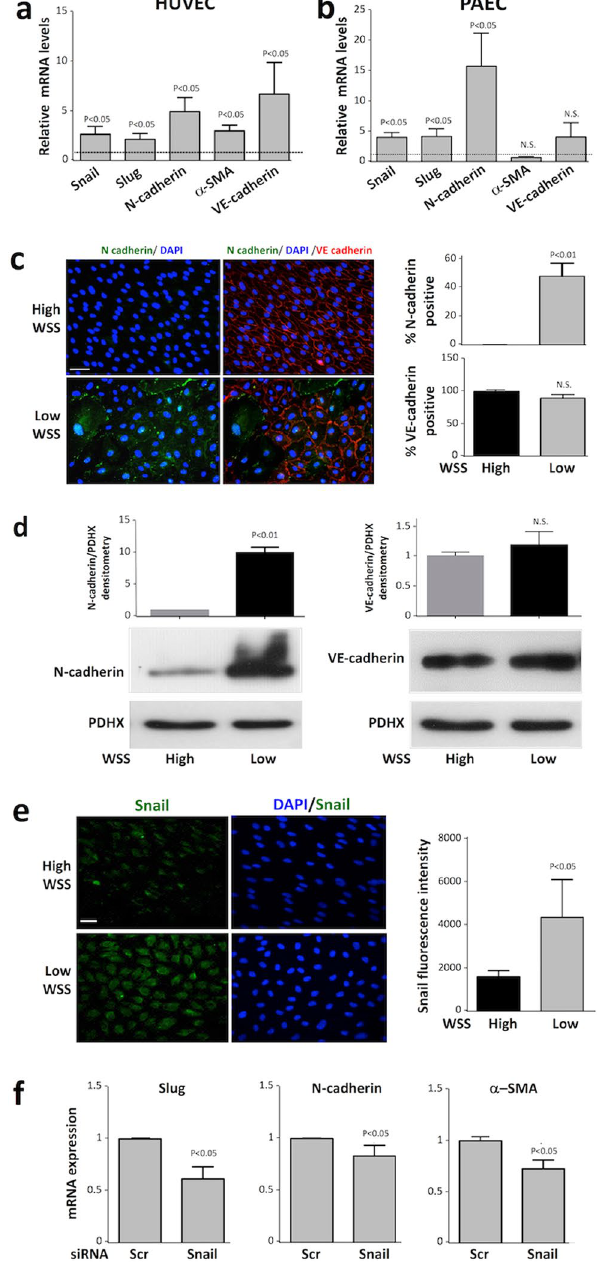
Figure 1. Low shear stress induced mesenchymal genes via Snail. ( a ) HUVEC were exposed to low oscillatory ( + / − 4 dyn/cm 2 ) or high (13 dyn/cm 2 ) wall shear stress (WSS) using a parallel plate system. ( b ) PAEC were exposed to orbital flow to generate low (5 dyn/cm 2 ) or high (15 dyn/cm 2 ) wall shear stress. ( a , b ) After 72 h, levels of EndMT marker transcripts and VE-cadherin transcripts were quantified by qRT-PCR. The expression level at the low WSS site is presented relative to the expression at the high WSS site (normalised to 1; dotted line). Data were pooled from six independent experiments using cells from different donors and mean levels + / − SEM are shown. ( c–e ) HUVEC were exposed to orbital flow to generate low (5 dyn/cm 2 ) or high (15 dyn/cm 2 ) WSS for 72 h. ( c ) Expression of N-cadherin (green) and VE-cadherin (red) was determined by immunofluorescent staining and co-staining using DAPI (blue). Scale bar, 50 μ m. The proportion of cells that expressed N-cadherin or VE- cadherin was measured. ( d ) The expression levels of N-cadherin (left) and VE-cadherin (right) were assessed by Western blotting using specific antibodies and anti-PDHX antibodies were used to control for total protein levels. Representative blots are shown. Bands were quantified by densitometry. ( e ) Expression of Snail (green) was determined by immunofluorescent staining and co-staining using DAPI (blue). Scale bar, 50 μ m. Fluorescence intensity was quantified in multiple cells. ( f ) HUVEC were transfected with siRNA targeting Snail or with scrambled sequences and exposed to orbital flow for 72 h. Cells exposed to low WSS (5 dyn/cm 2 ) were collected and transcript levels of Slug, N cadherin and α -SMA were quantified by qRT-PCR. ( c – f ) Data were pooled from three independent experiments using cells from different donors and mean levels + / − SEM are